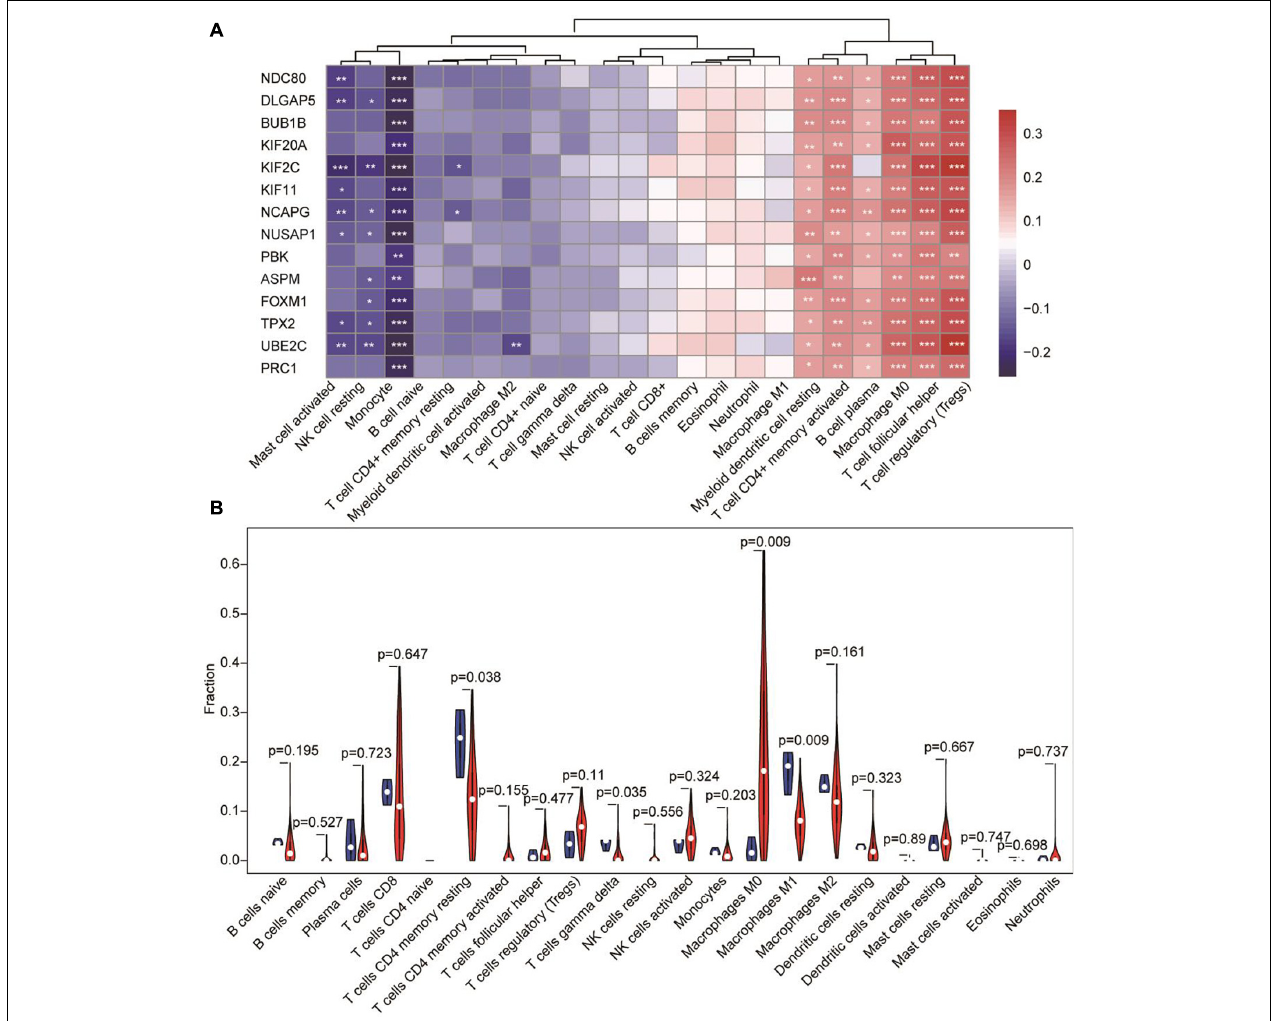
FIGURE 6 | The correlation between hub genes-immune cells and the fraction of infiltrated immune cells between normal tissue and tumor tissue in HCC. (A) The expression of candidate hub genes having significant positive correlations with immune infiltration cells are shown in red. The expression of candidate hub genes having significant negative correlations with immune infiltration cells are shown in blue. * p < 0.05, ** p < 0.01, *** p < 0.001. (B) Fraction of infiltrated immune cells in HCC. Red represents tumor tissue and blue shows normal